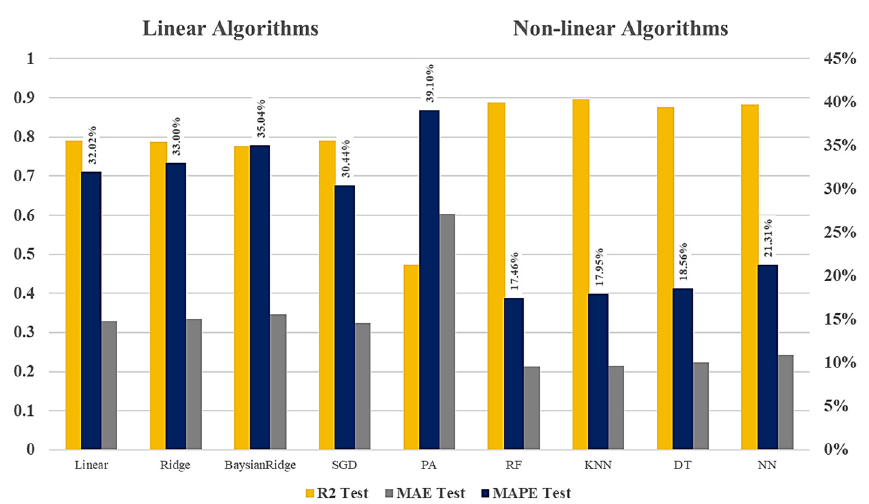
Figure 6. Comparison of different models, best performance on the test data set for total PVs for the average error of cross validation over four splits.